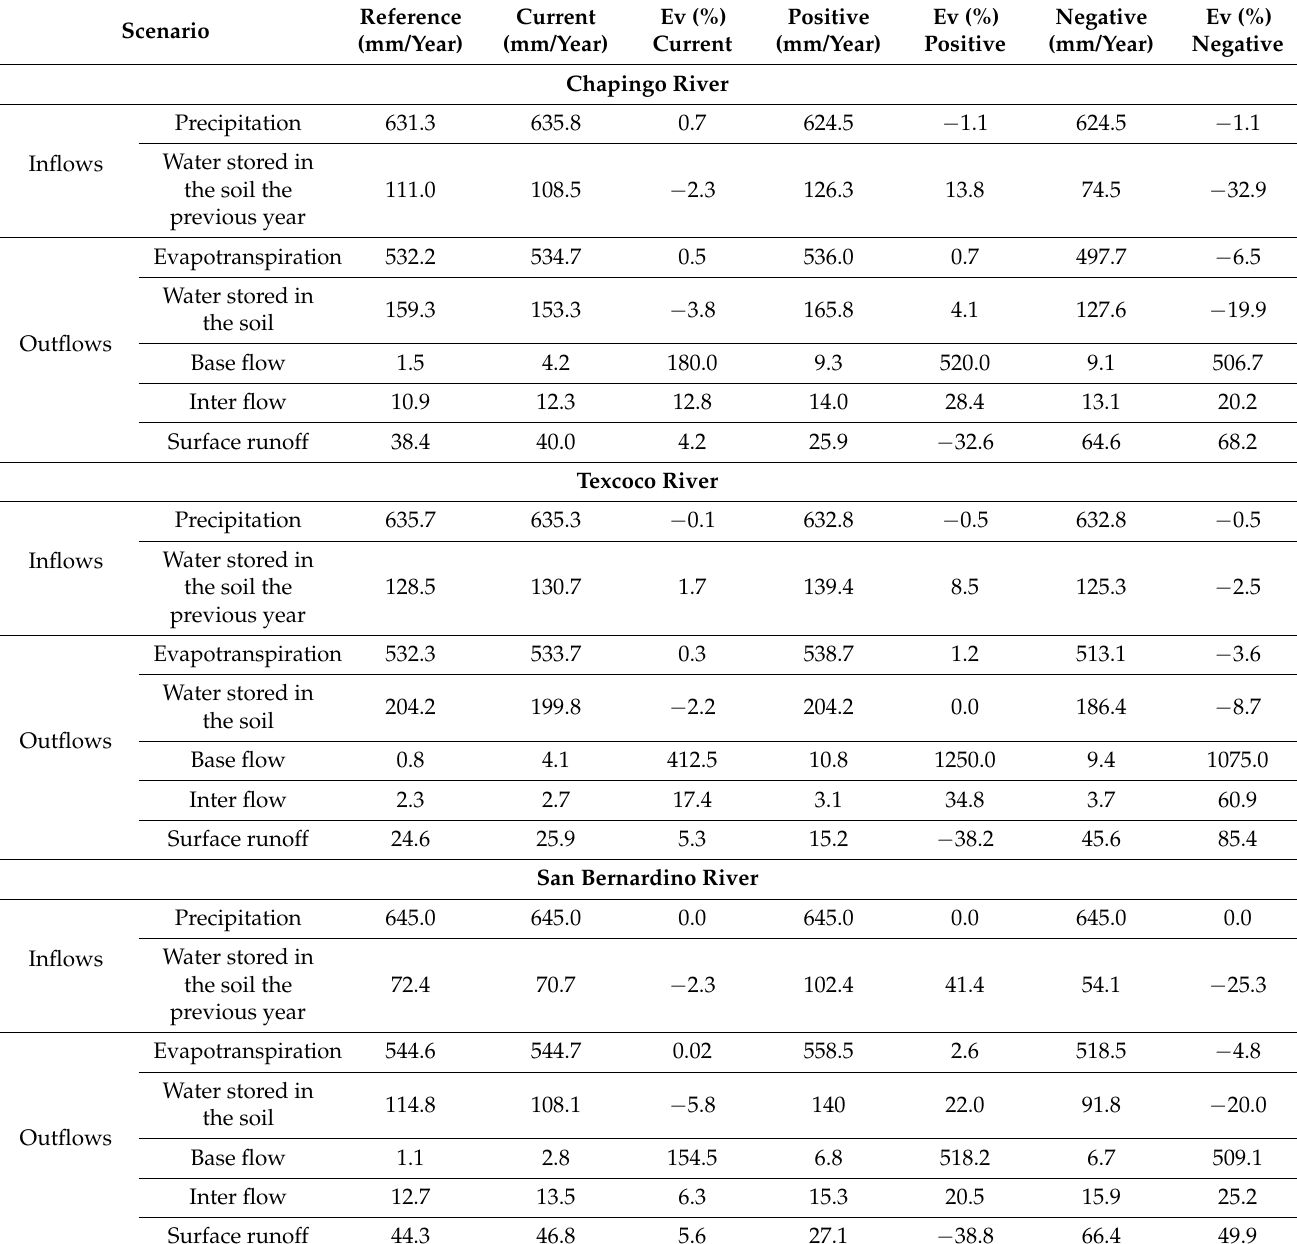
Table 7. Inflow and outflow of the hydrological balance of the Chapingo River, Texcoco River, and San Bernardino